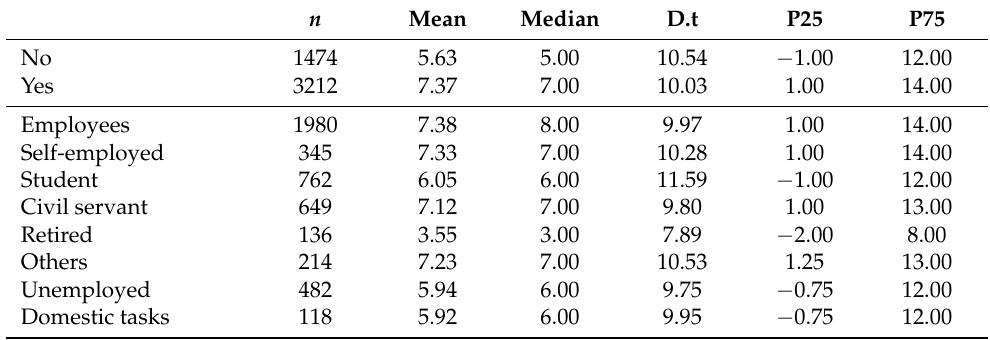
Table 4. Difference between state and trait anxiety, “Do you have a job?”, and employment situation.